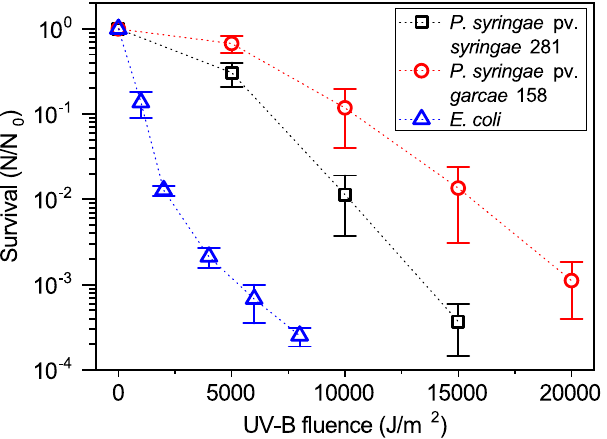
Figure 4. Survival curves to UV-B (312 nm) radiation. P. syringae strains were exposed as 5 × 10 6 cells/ml suspensions, and E. coli as 5 × 10 7 cells/ml. P. syringae pv. syringae 281 and P. syringae pv. garcae 158 are shown